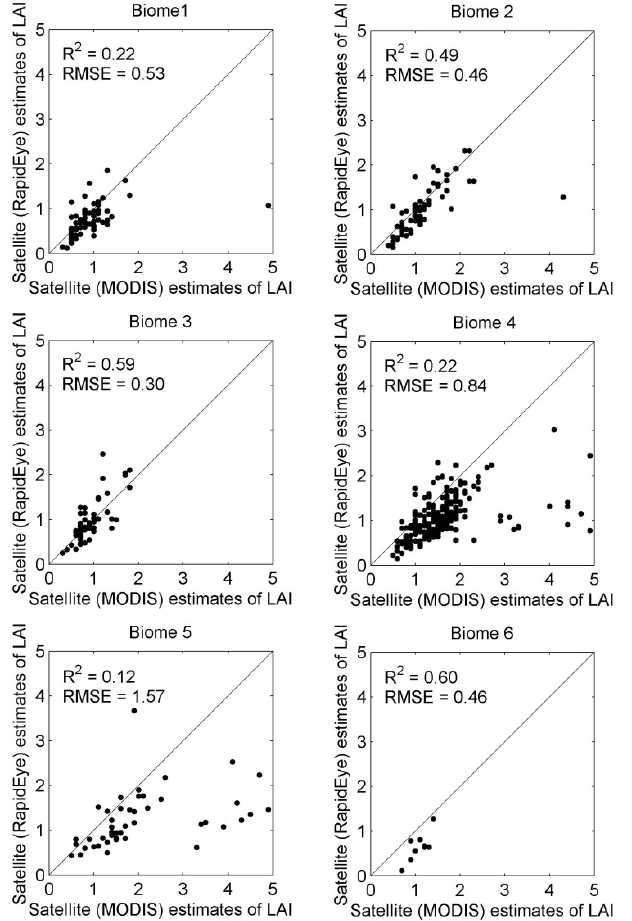
Figure 8. Comparison between MODIS LAI and RapidEye LAI aggregated at 1 km spatial resolution based on the position of MODIS pixels. Results are presented according to the MODIS biome classification scheme (Biome 1: grasses and cereal crops; Biome 2: